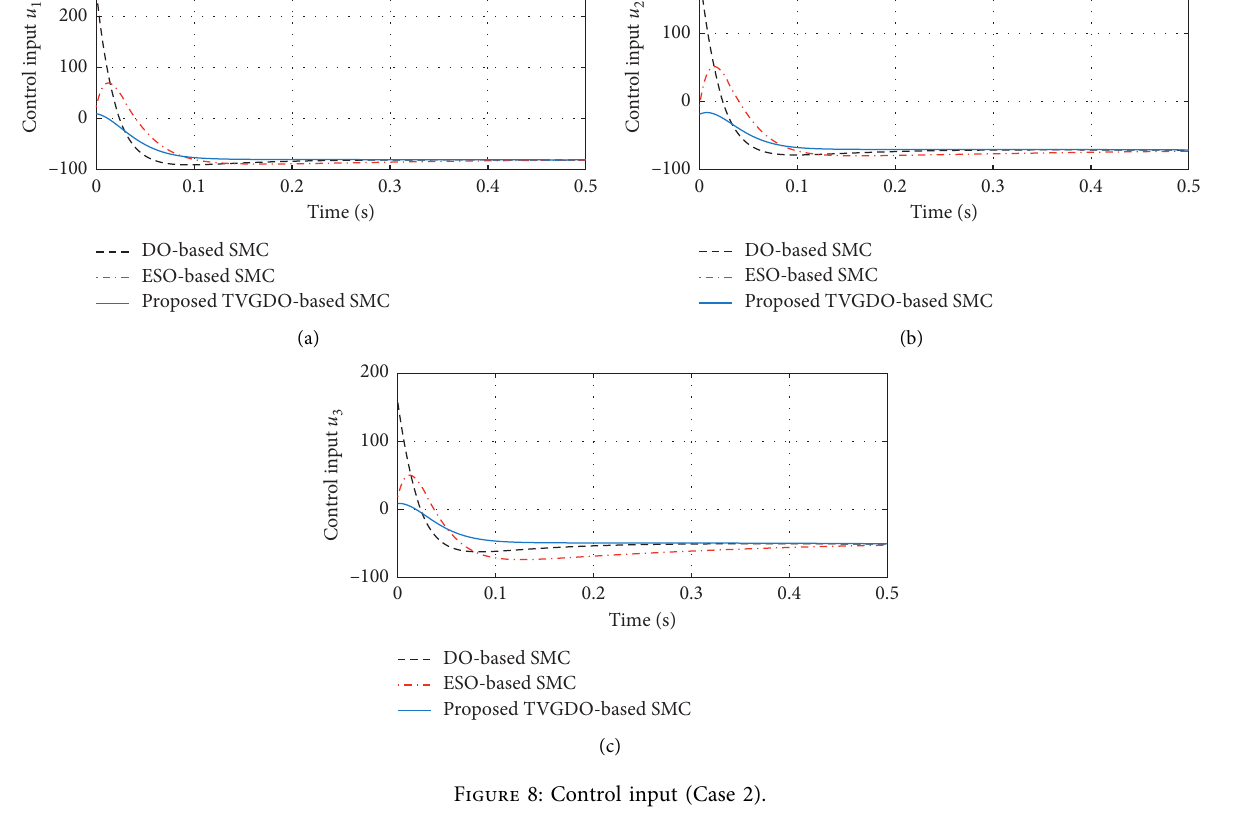
Figure 8: Control input (Case